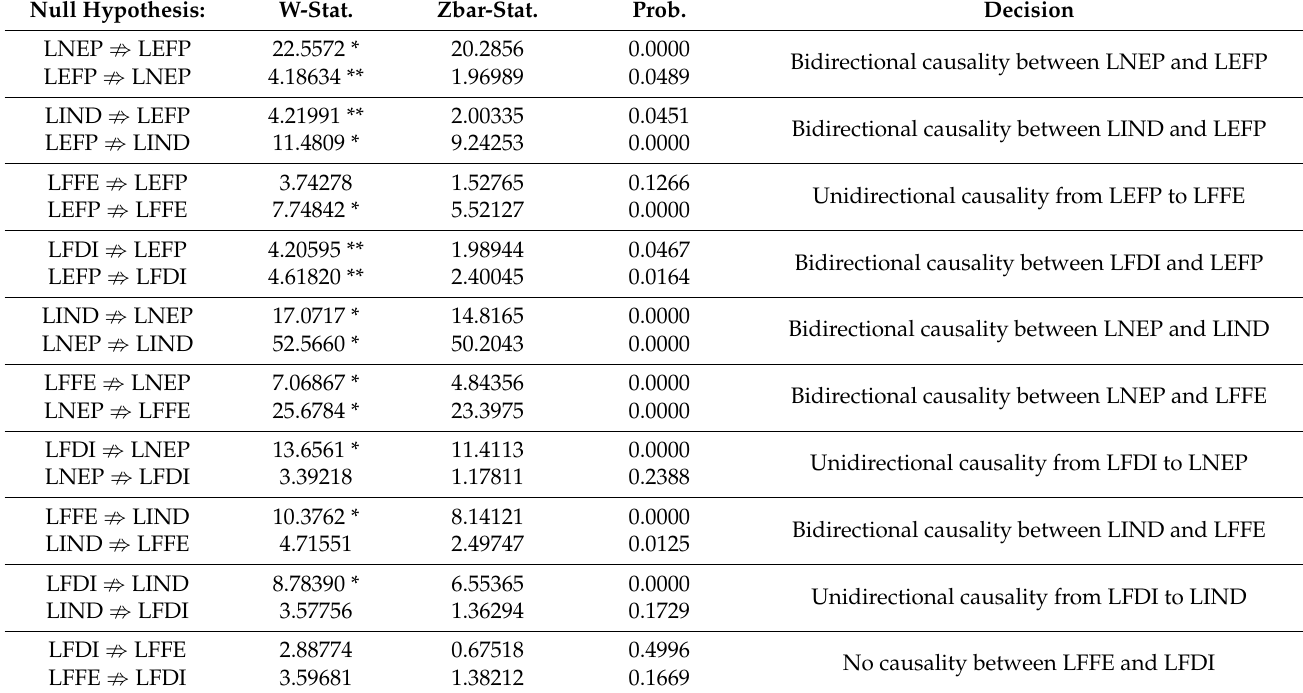
Table 8. Panel Dumitrescu and Hurlin causality